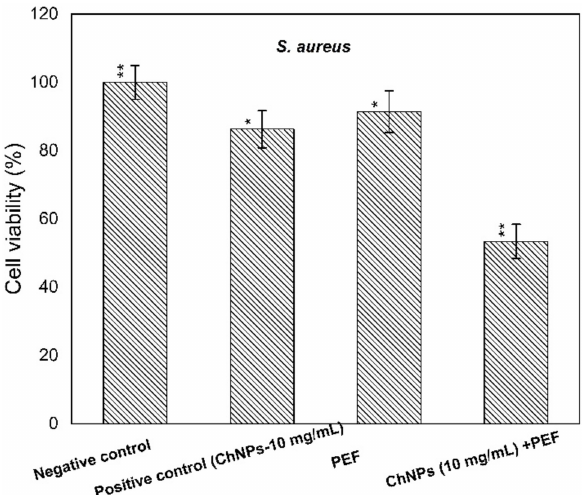
Figure 4. Cell viability percentages of S. aureus relative to control bacterial counts. * statistically significant, ** statistically highly